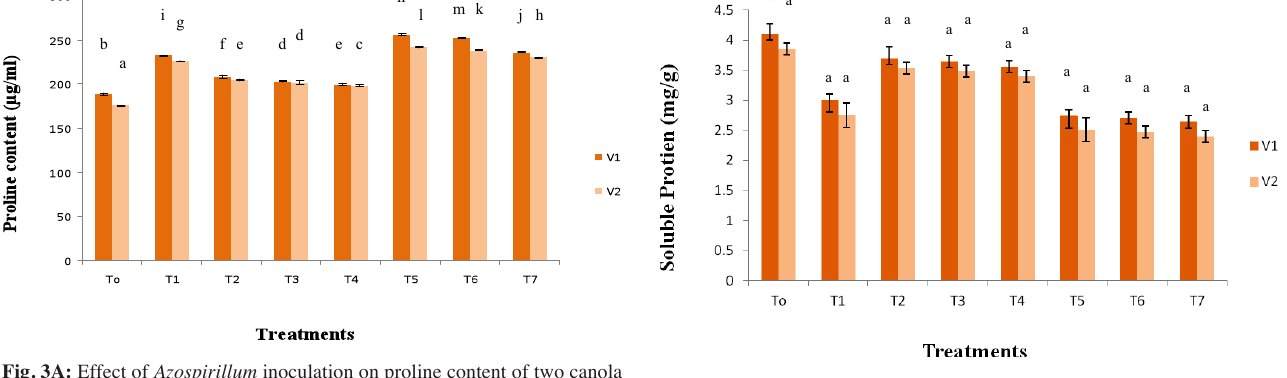
Fig. 3C: Effect of Azospirillum inoculation on soluble protein of two canola varieties (v1 and v2) grown under drought stress. Where, To = Un-inoculated and well watered, T = Un-inoculated and drought exposed, T2 = Seed inoculated and well watered, T3 = Rhizosphere inoculated and well watered, T4 = Seed inoculated with heat killed inoculums and well watered, T5 = Seed inoculated and drought exposed, T6 = Rhizosphere inoculated and drought ex- posed, T7 = Seed inoculated with heat killed inoculums and drought exposed. And V1 = Rainbow, V2 = Con II.